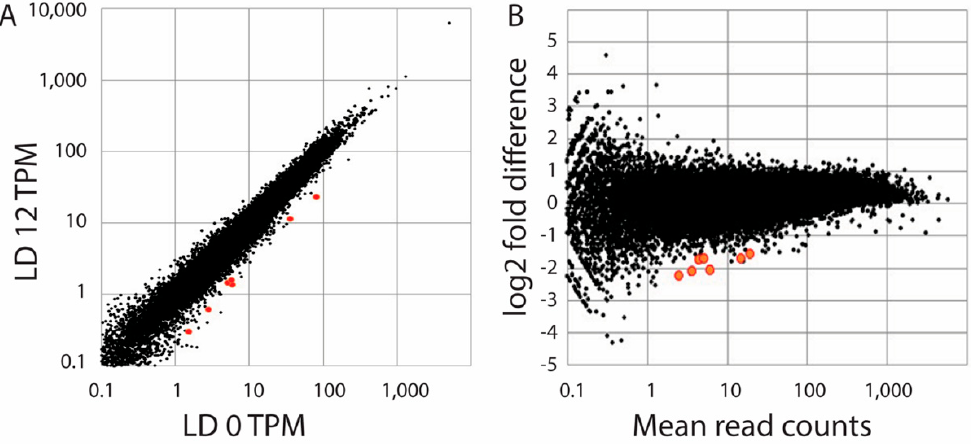
Figure 2. Northern blot analysis of three potentially light regulated transcripts. A representative sample of northern blots ( n = 4) using either an rbcL , an oee1 , an acppc , or an Actin cDNA as a probe. RNA was prepared from samples taken every four hours from cells grown under a normal 12:12 LD cycle as well as from cells grown under high light (note that LD 0 and LD 24 should be identical). At right, densitometric scans for the top three probes are shown relative to the Actin signal.